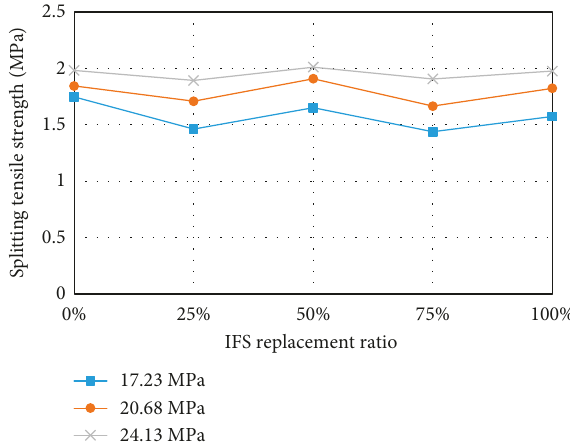
Figure 16: Splitting tensile strength for concrete with different IFS